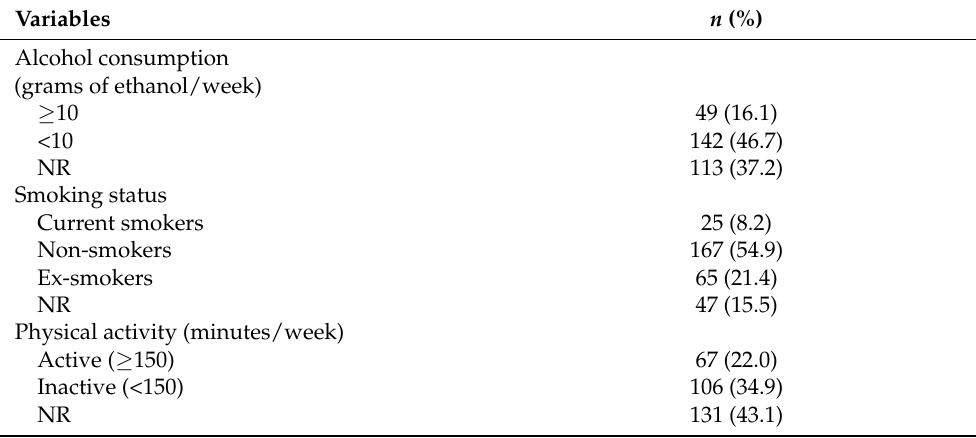
Table 3. Behavioral variables of breast cancer women undergoing CT ( n = 304), Brazil,